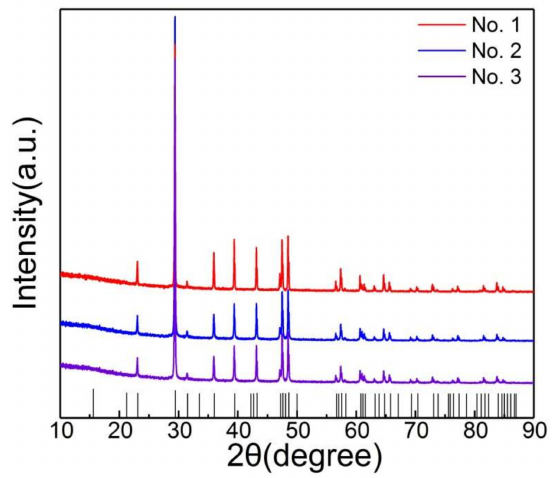
Figure 2. XRD of the three